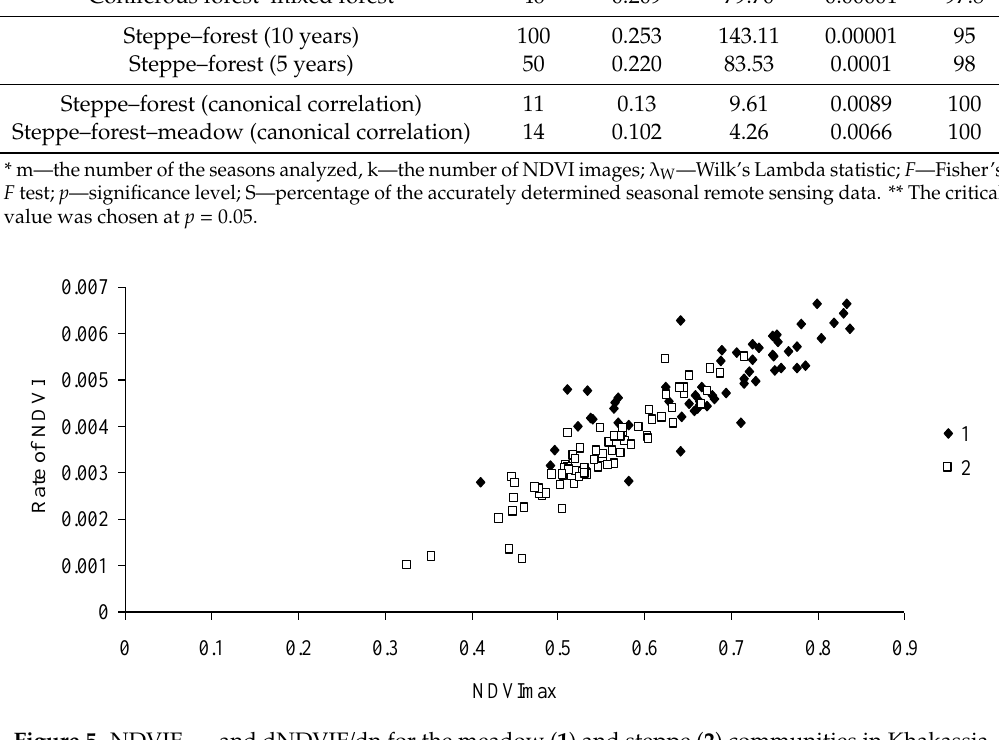
Figure 5. NDVIF max and dNDVIF / dn for the meadow ( 1 ) and steppe ( 2 ) communities in Khakassia.